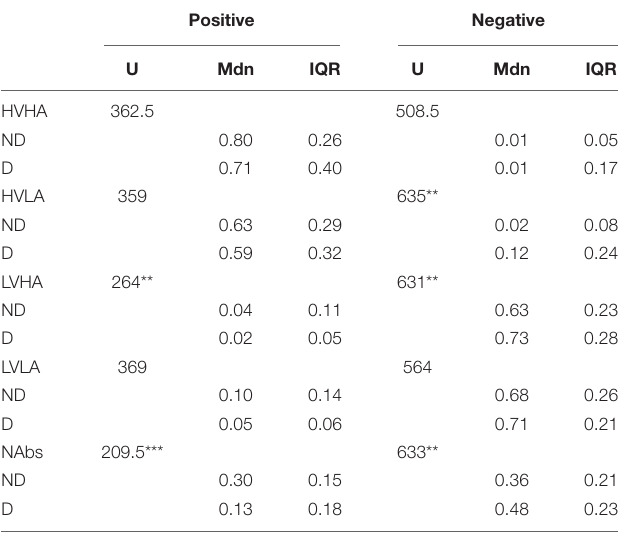
TABLE 5 | Polarity ratings calculated by TweetEval for stimuli categories.